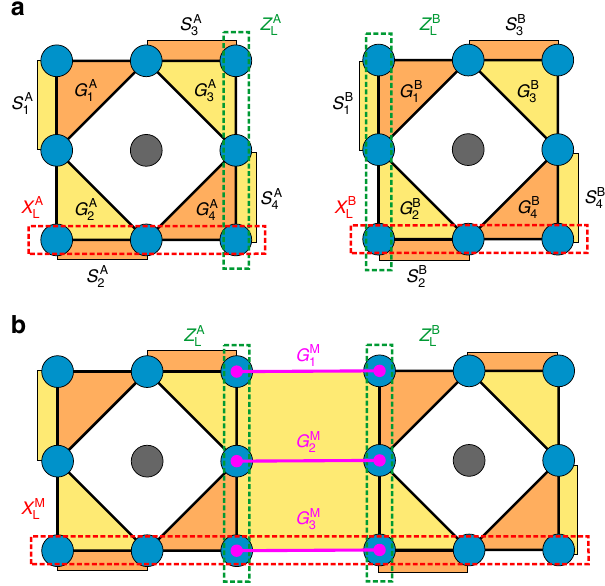
and Z I are L L